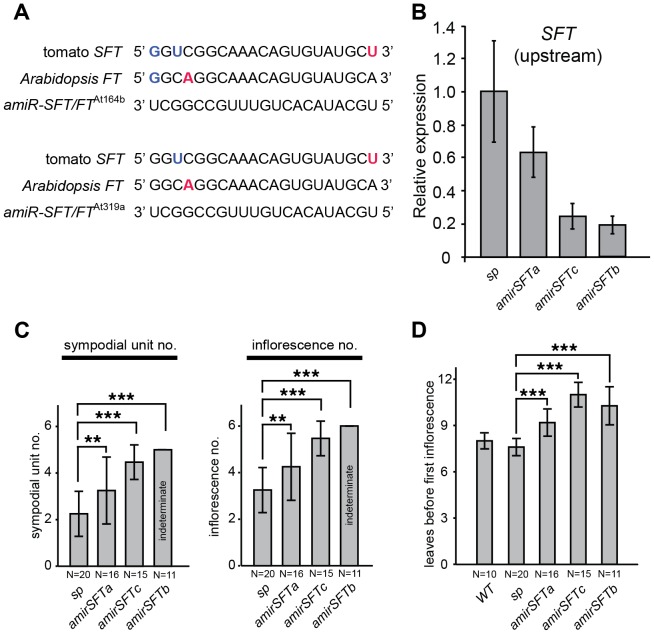
Reducing SFT transcripts with artificial microRNAs mimics the dosage effects of sft/+ heterozygosity.(A) Artificial microRNAs targeting tomato SFT and Arabidopsis FT. Shown are alignments of amiR-SFT/FTAt
164b and amiR-SFT/FTAt
319a with the complementary region of SFT and FT. G–U wobbles and mismatches between the two amiR-SFT/FTs and the target are highlighted in the target sequence with bold blue and red, respectively. (B) Quantitative RT-PCR measurements of tomato SFT transcript levels in amirSFT plants showing knock down. Results shown are from using primers targeting SFT transcripts 5′ to the amiRNA binding site, consistent with reports of primer-dependent transitivity occurring at the 3′ to 5′ direction upon the initial target cleavage, resulting in degradation of the 5′ cleaved product of the target but not the 3′ product [80], [81] (Figure S2). Bars indicate relative expression level and error bars indicate standard deviation among replicates. (C) Depending on the strength of suppression, amirSFT plants produce at least one additional sympodial unit and inflorescence compared to sp alone, indicating that reducing SFT transcript levels by artificial microRNA partially suppresses sp sympodial termination, mimicking the dosage effect of sft/+ heterozygosity. Note that some amirSFTc progeny plants showed indeterminacy, whereas amirSFTb progeny plants were always indeterminate, indicating that a stronger suppression of SFT completely suppresses the sp phenotype and reverts the plants to normal sympodial cycling. Differences in sympodial unit and inflorescence numbers between amirSFT and sp plants were tested by Wilcoxon rank sum test and significance levels are marked by asterisks (* P<0.05, ** P<0.01, *** P<0.001). (D) amirSFT plants have delayed primary shoot flowering time compared to sp and WT controls, similar to sft/+ heterozygosity. Bars indicate average leaf numbers with standard deviations. Genotypes and sample sizes are shown below. Differences in leaf numbers between amirSFT and sp plants were tested by Wilcoxon rank sum test and significance levels are marked by asterisks (* P<0.05, ** P<0.01, *** P<0.001).